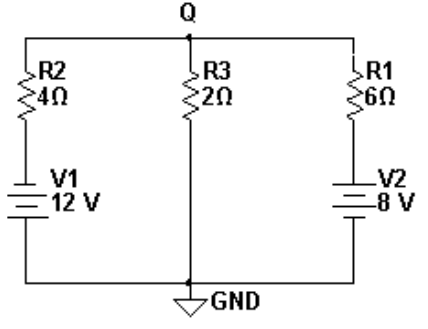
Fig. 3. Re-drawn circuit to emphasize common nodes and choose ground reference